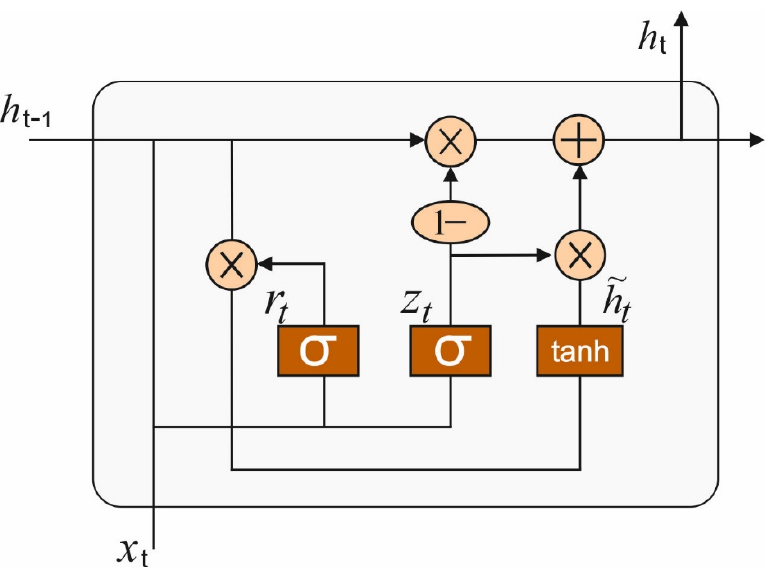
Figure 3. GRU framework.